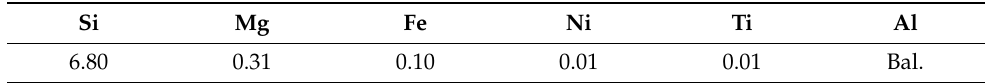
Table 1. Chemical composition of Al-Mg-Si alloy (AC4CH)